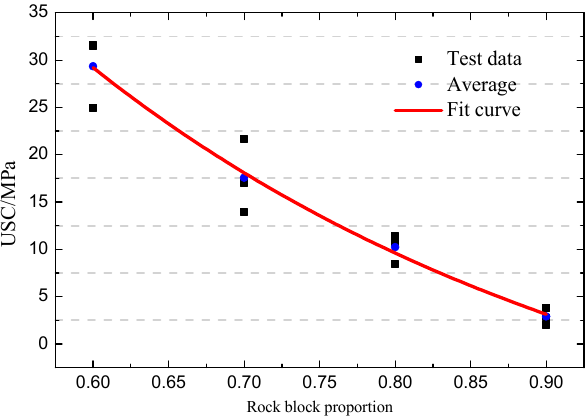
Figure 8. Distribution curve of UCS of specimens with different RBPs. Table 1. The UCS values for the bimrocks with the various RBP.